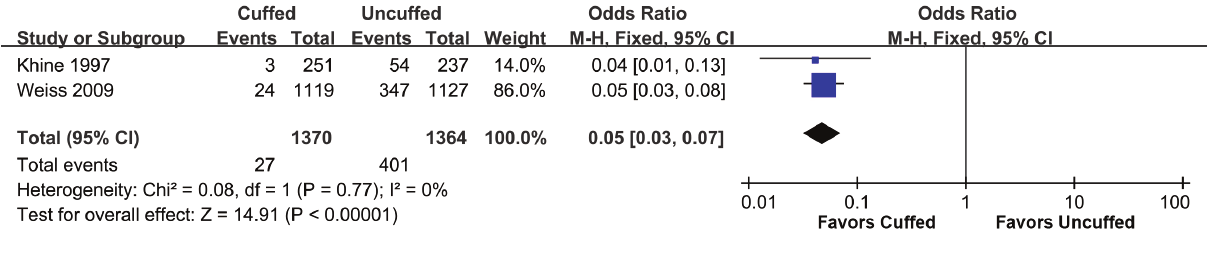
Figure 2: The meta-analysis of tube changes between cuffed and uncuffed groups. Table 3: The meta-analysis results of post-extubation parameters.